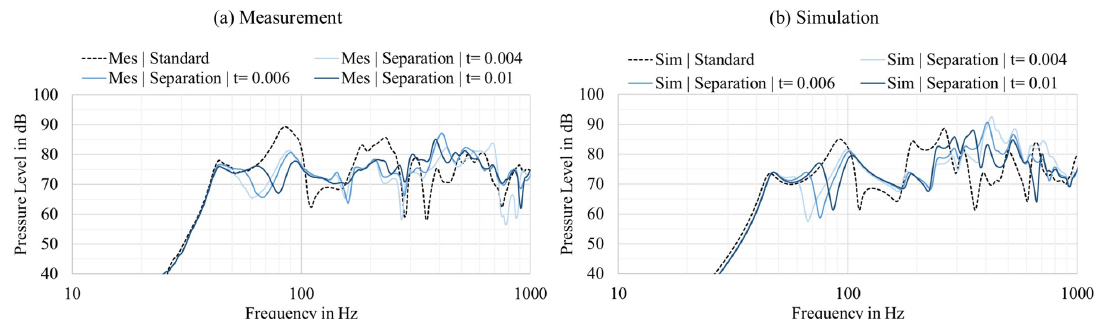
Figure 15. Comparison of the influence of the thickness of the paneled volume: ( a ) measurement; and ( b ) simulation.